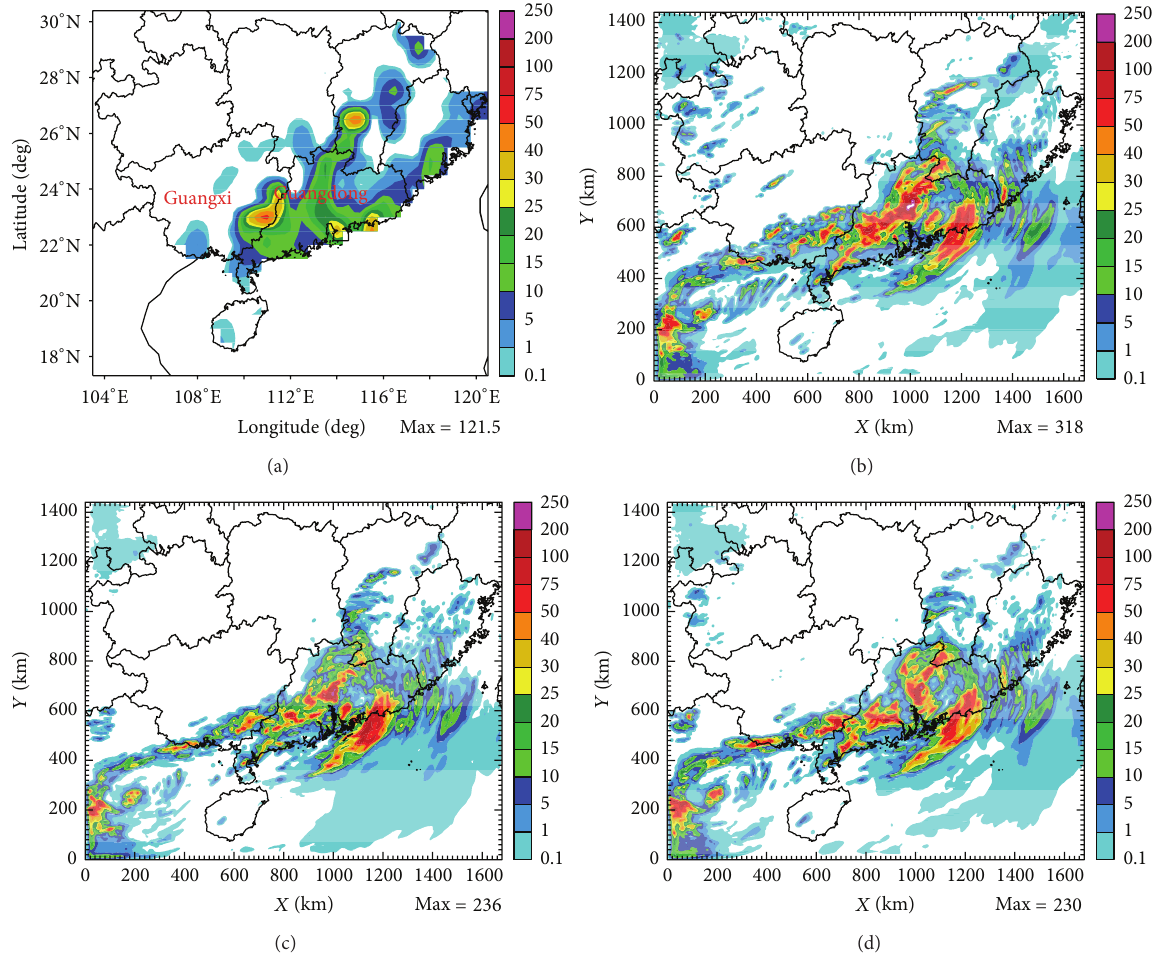
Figure 8: 6h accumulated precipitation from (a) observations, (b) CNTL, (c) RADSND, and (d) ALLDATA between 1200 and 1800 UTC July 15, 2011 for case